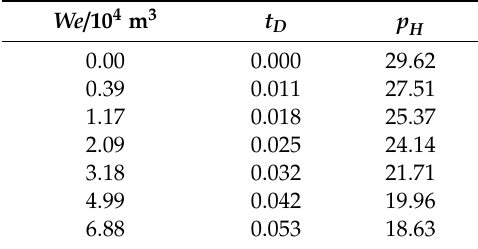
Table 3. Water influx of gas reservoir Z1.